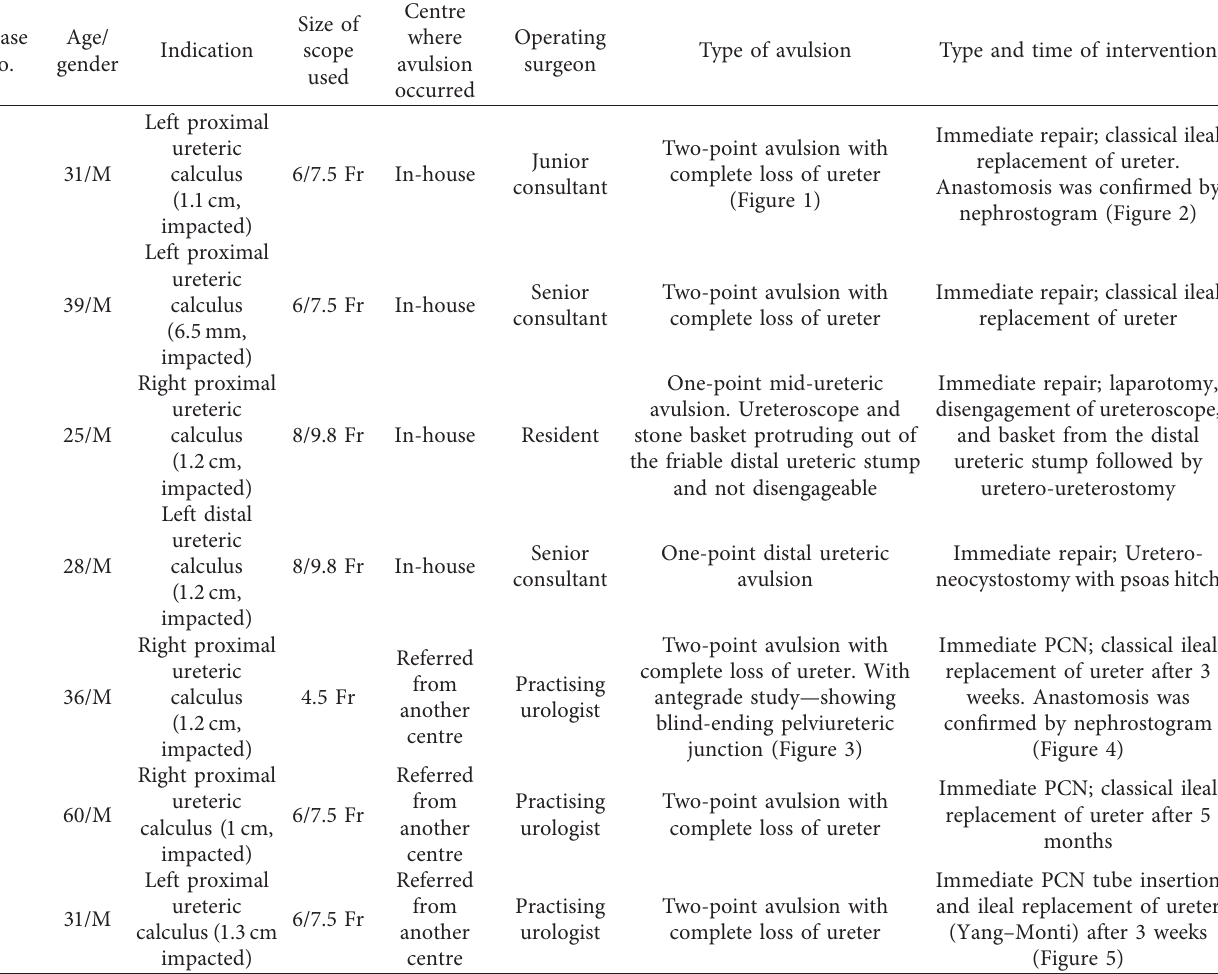
Table 1: Clinical summary of 7 patients and their management.